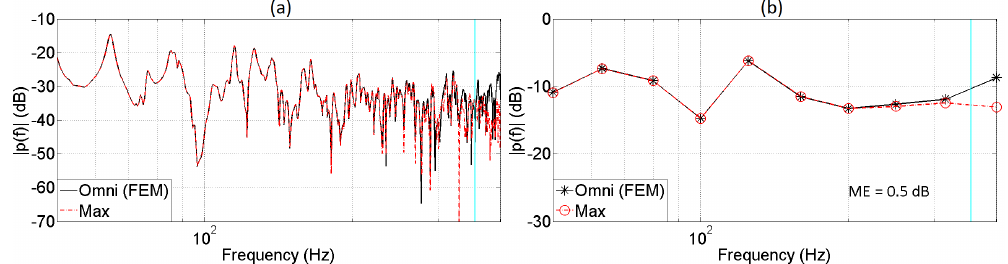
Figure 22. Comparison of full ( a ) and 1/3 octave band ( b ) frequency responses. Translated PWE and omnidirectional room impulse response (FEM) at translated Position 3.